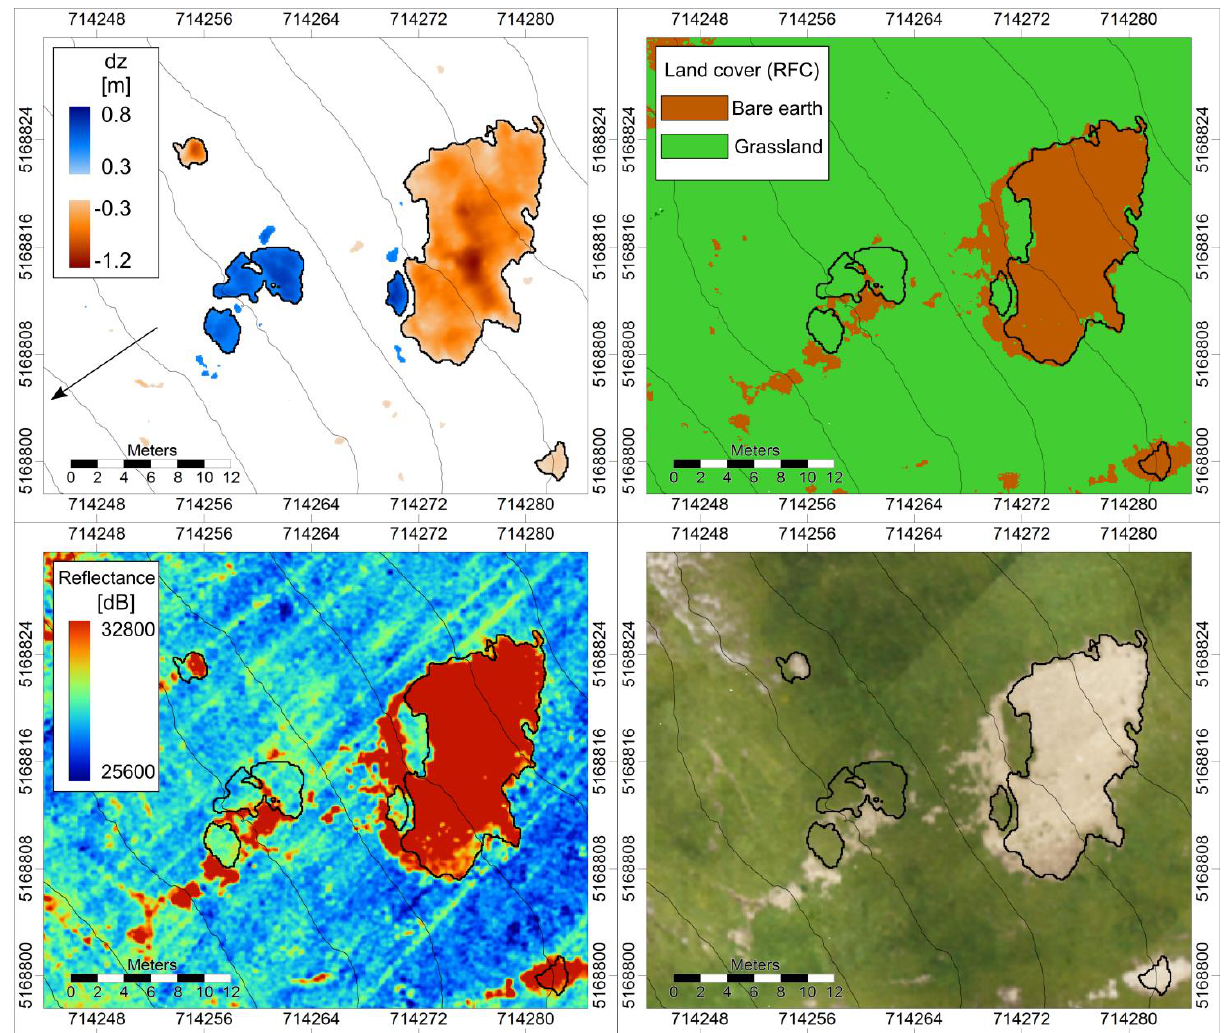
Figure 6. Example of change objects mapping with (clockwise from upper left) (i) elevation change between 2010 and 2018, (ii) Random Forest classification (RFC; no trees in this subset), (iii) RGB orthoimage, (iv) reflectance. Change objects (|dz| > 0.3 m) are outlined by black polygons. Contour equidistance is 5